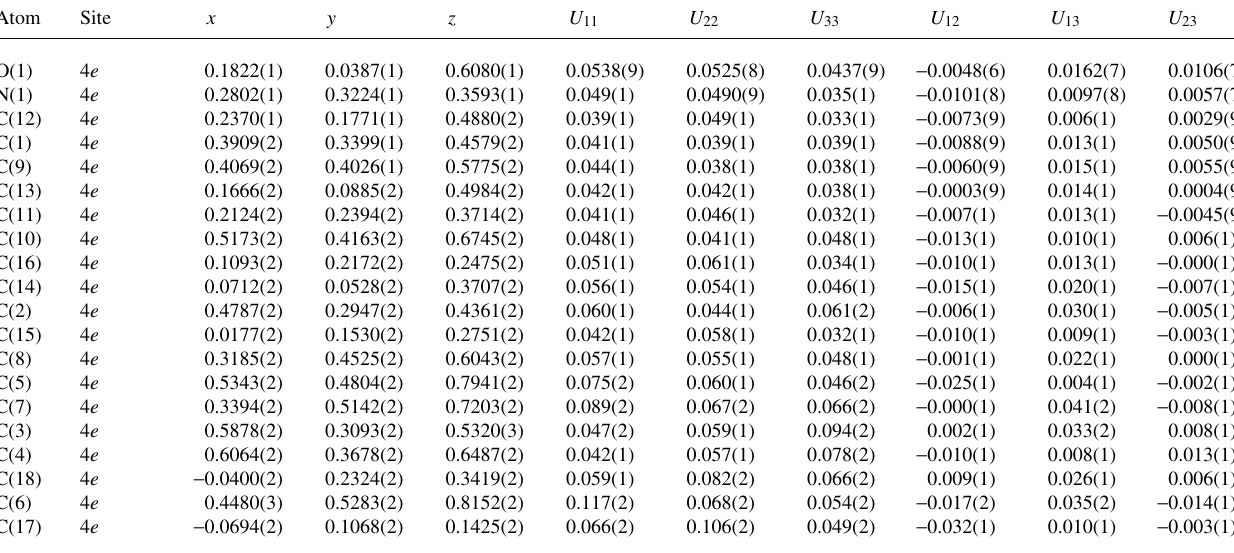
Table 3. Atomic coordinates and displacement parameters (in Å 2 )